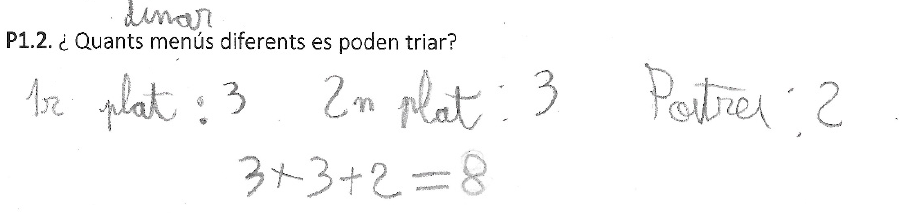
Figure 2. Incorrect answer of Q2. Wrong additive strategy. CC1 cognitive conflict (translation: starter: 3; main course: 3; dessert: 3).